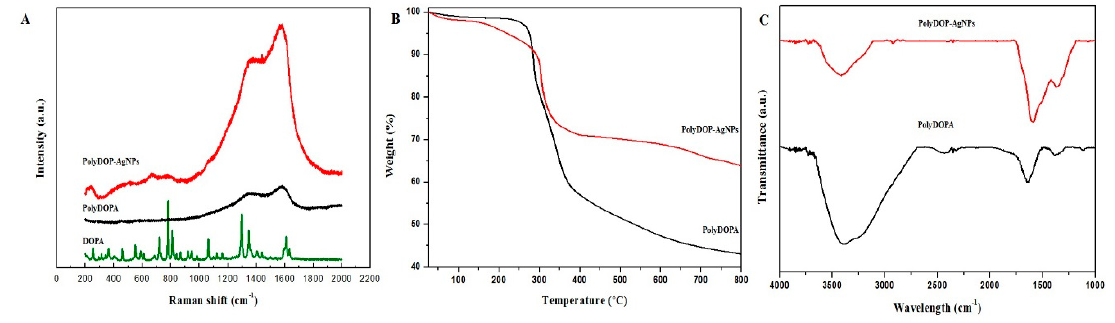
Figure 2. ( A ) Raman spectra; ( B ) TGA curves; and ( C ) FTIR spectra of polyDOPA and polyDOPA-